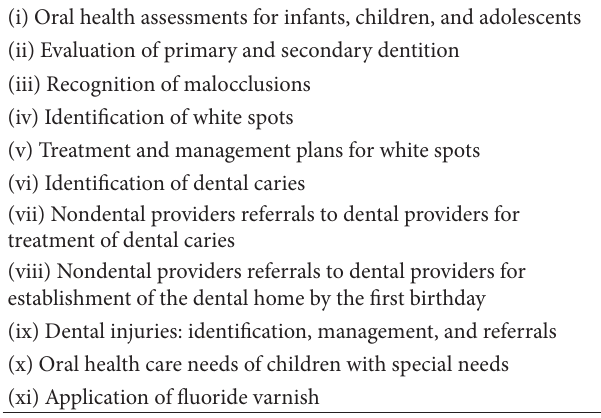
Table 2: Interprofessional performance oral health core competen-